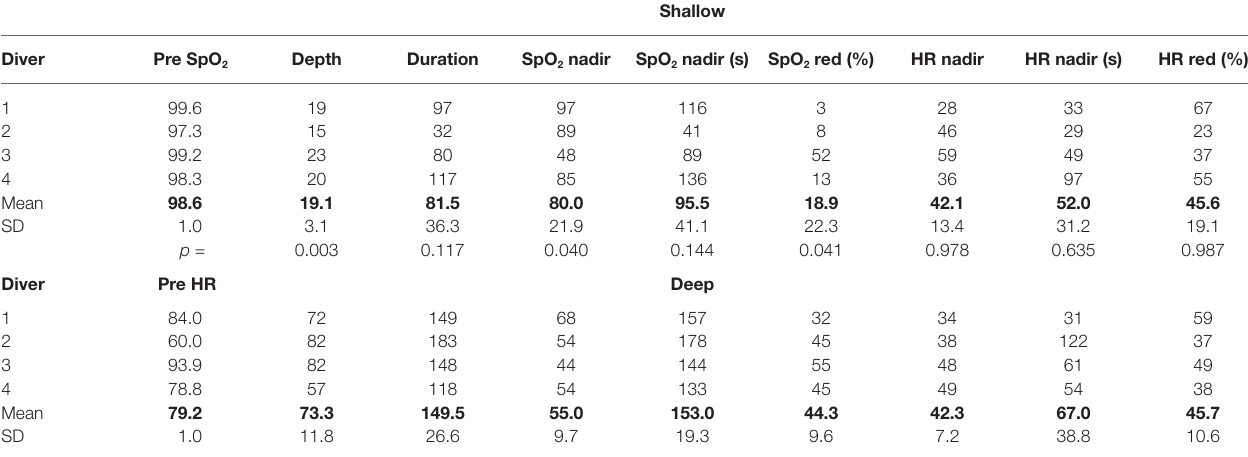
TABLE 1 | Individual and mean (SD) baseline reference values of SpO 2 and HR during a period of immersed rest before dives, followed by depths, durations, and nadir SpO 2 (%) and HR (bpm) values during deep and shallow dives; time when nadir occurs is noted as seconds from start of the dive, as well as the maximal reduction from pre-dive SpO 2 /HR reference values (%).